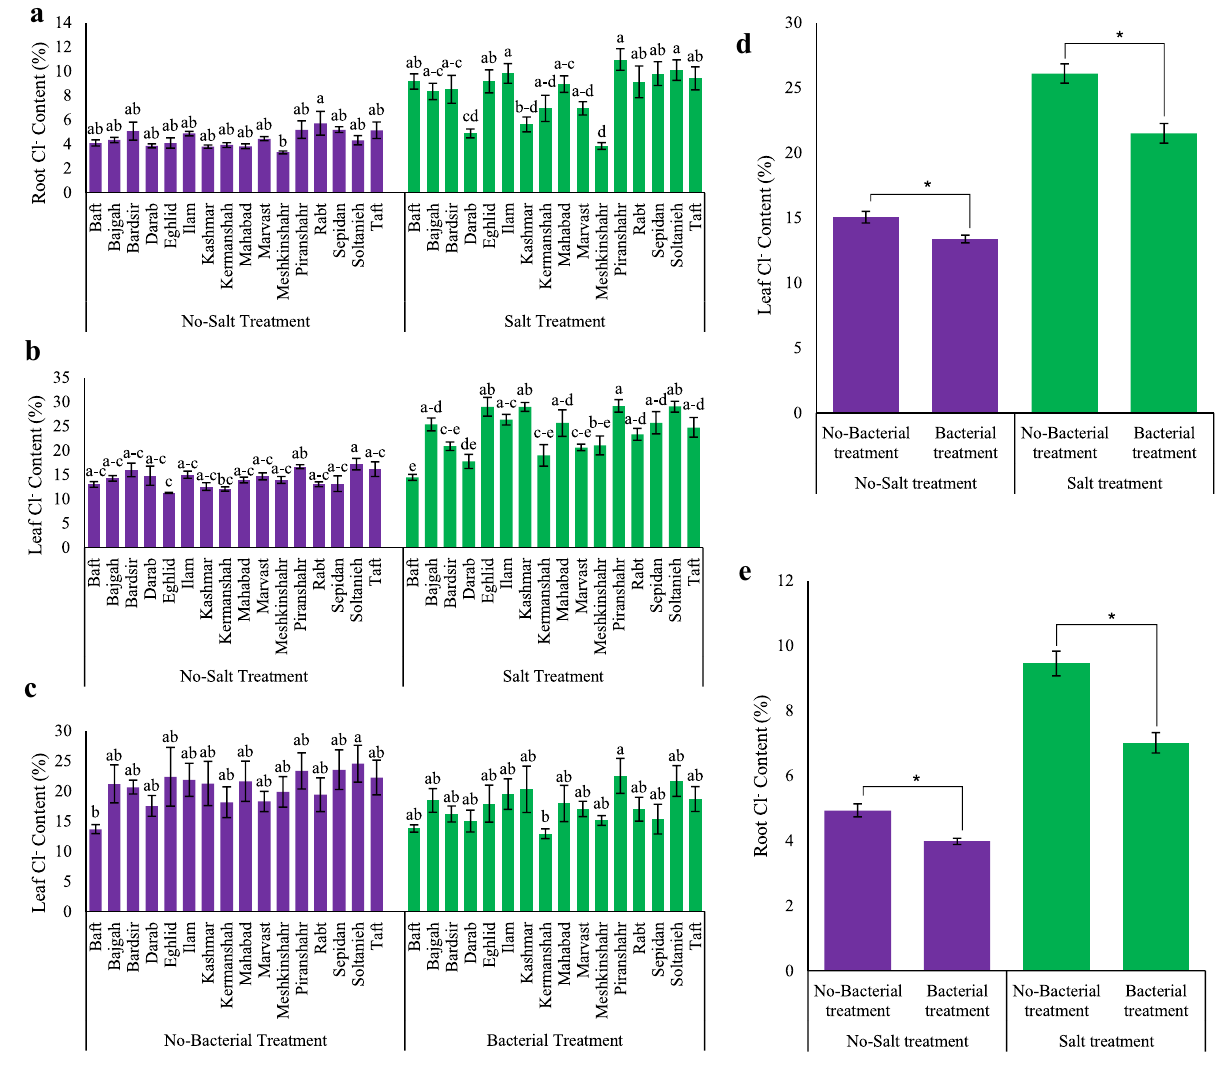
Figure 6. Measured parameters variation under studied treatments. ( a , e) Root Cl − content and ( b , c , d ) Leaf Cl − content. According to the analysis of variance, only the multiple effects of Azotobacter and salinity showed a significant difference, just its mean comparison is shown. Mean values with the same letters are not significantly different ( p ≤ 0.05), Tukey test. Bars stand for standard error